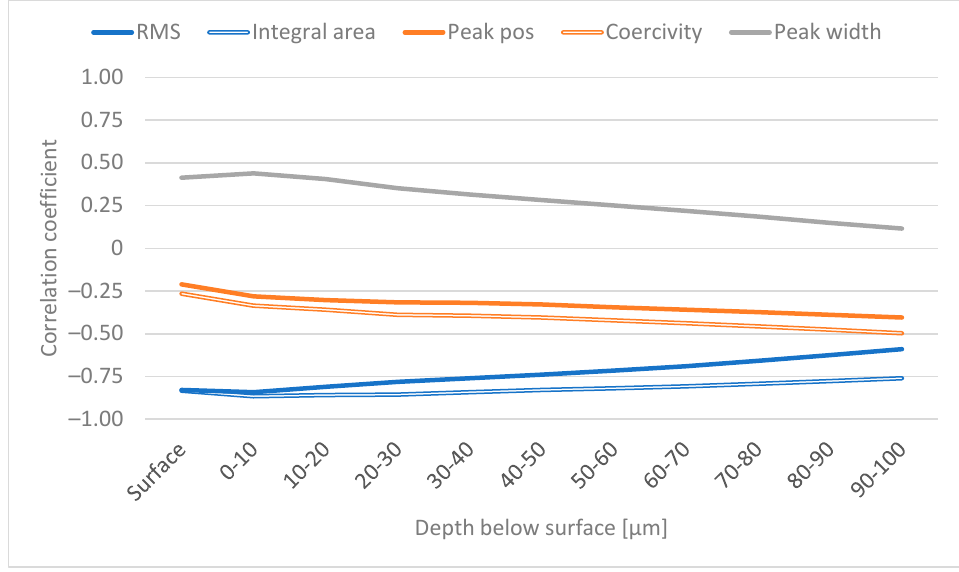
Figure 5. Correlation coefficient between selected BN features and XRD FWHM (tangential).